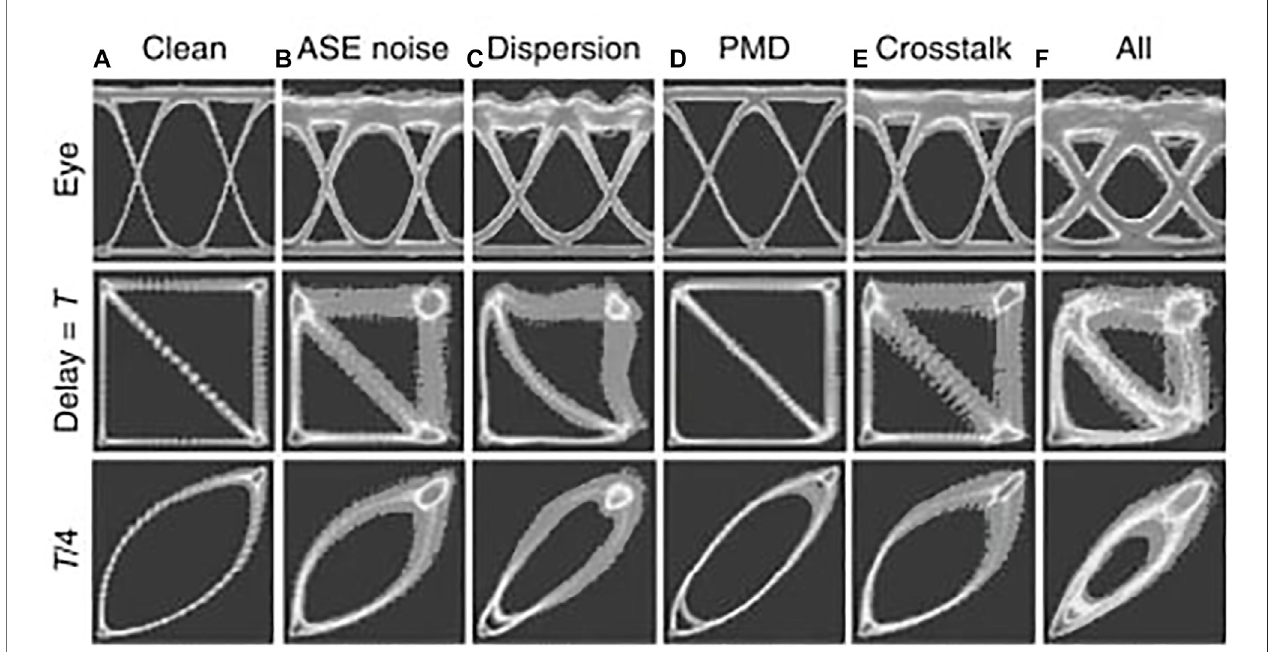
FIGURE 6 | ADTP ’ s for a 10 Gb/s NRZ signal in the following scenarios: (A) OSNR (cid:1) 35 dB, (B) OSNR (cid:1) 25 dB, (C) CD (cid:1) 800 ps/nm, (D) DGD (cid:1) 40 ps, (E) crosstalk (cid:1) − 25 dB and (F) a combination of (B – F) (Chan, 2010).